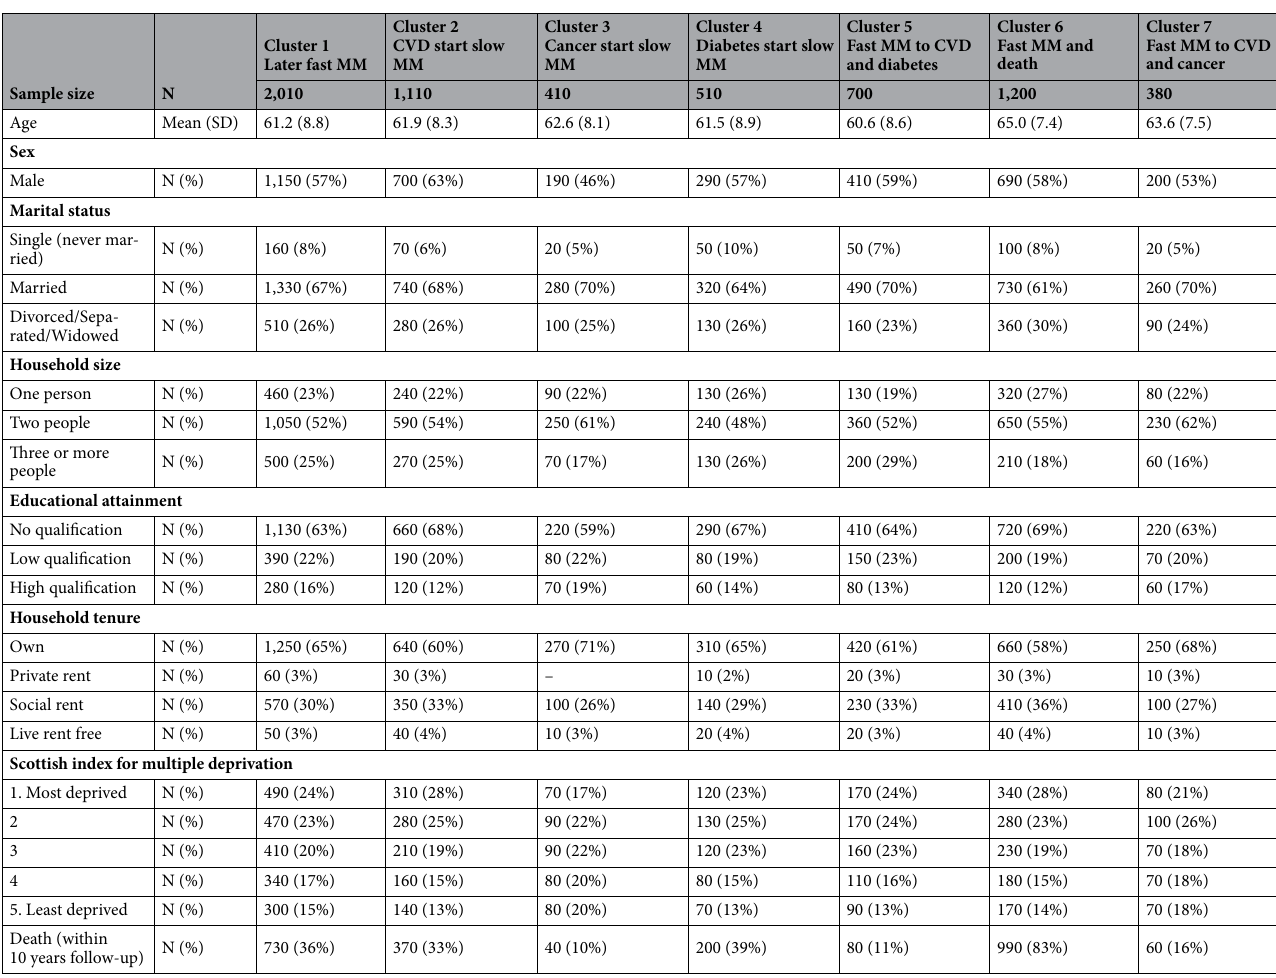
Table 3. Socio-demographic profile of the seven typical disease trajectory clusters. Source: Scottish Longitudinal